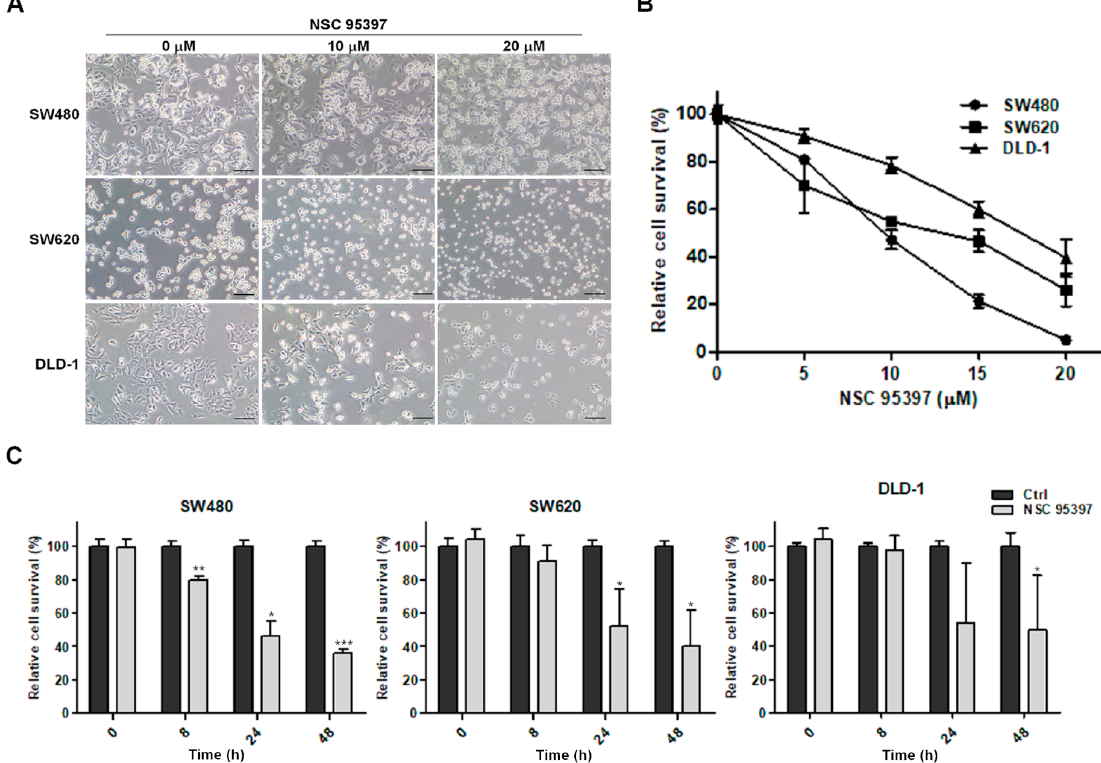
Figure 1. Inhibitory effect of NSC 95397 on cell viability in human colon cancer cells. ( A ) Morphological changes of SW480, SW620, and DLD-1 cells after exposure to NSC 95397 for 24 h. Scale bars represent 100 µm; ( B ) Cell viability (mean ± SD) of SW480, SW620, and DLD-1 cells treated with indicated concentrations of NSC 95397 for 24 h assessed by MTT assay; ( C ) Cell viability of SW480, SW620, and DLD-1 cells treated with 10 µM NSC 95397 for indicated times assessed by MTT assay. Values are means + SD; * p < 0.05; ** p < 0.01; and *** p < 0.001 using unpaired t -tests with Welch’s correction, compared to relative control group.